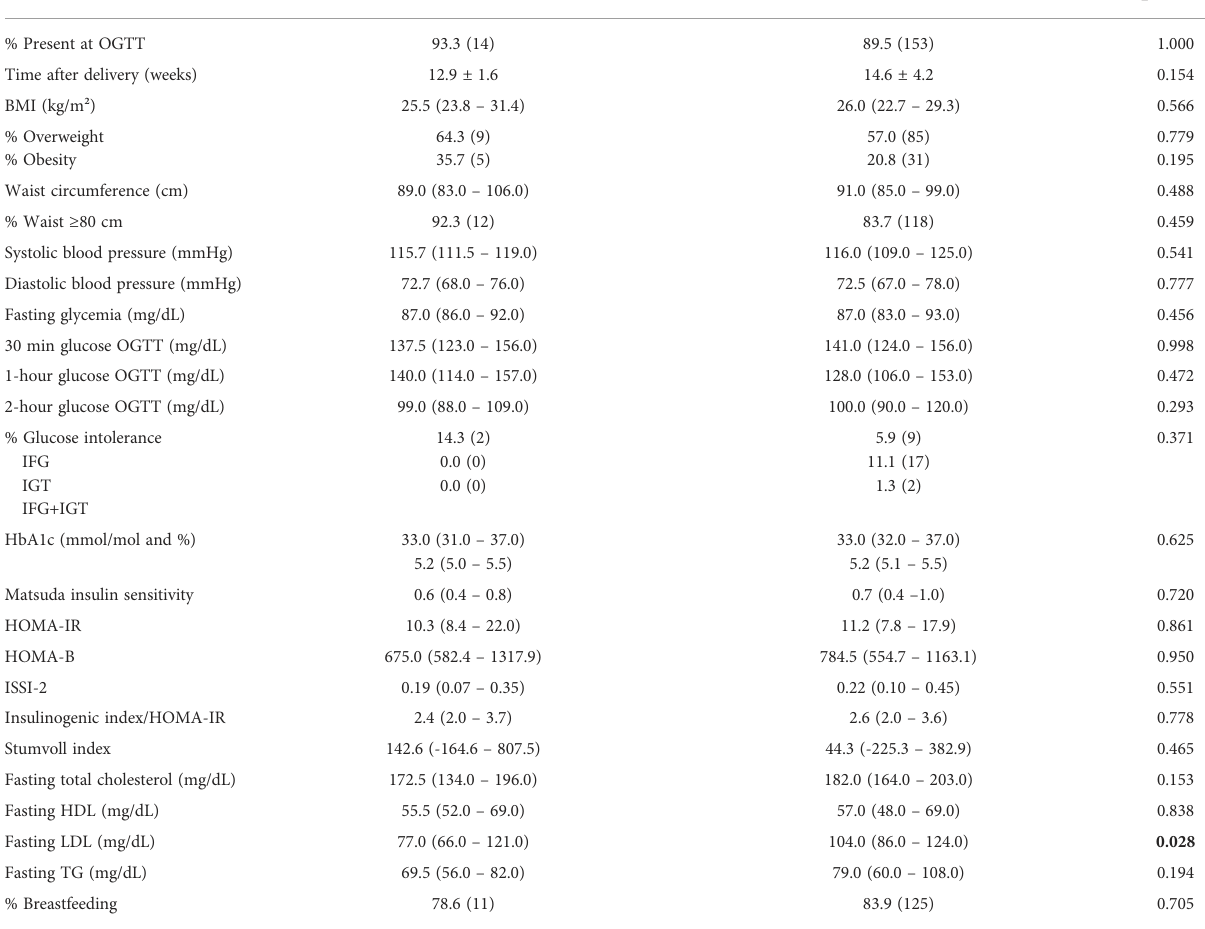
TABLE 3 Comparison of characteristics between GDM with autoantibodies and GDM without autoantibodies at the early postpartum OGTT. GDM with autoantibodies N=14